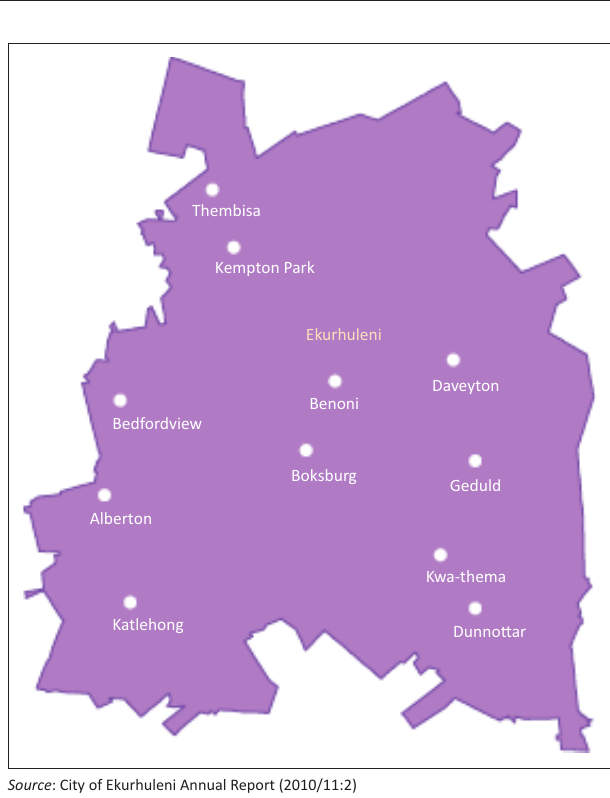
FIGURE 1: Map for Ekurhuleni Metropolitan